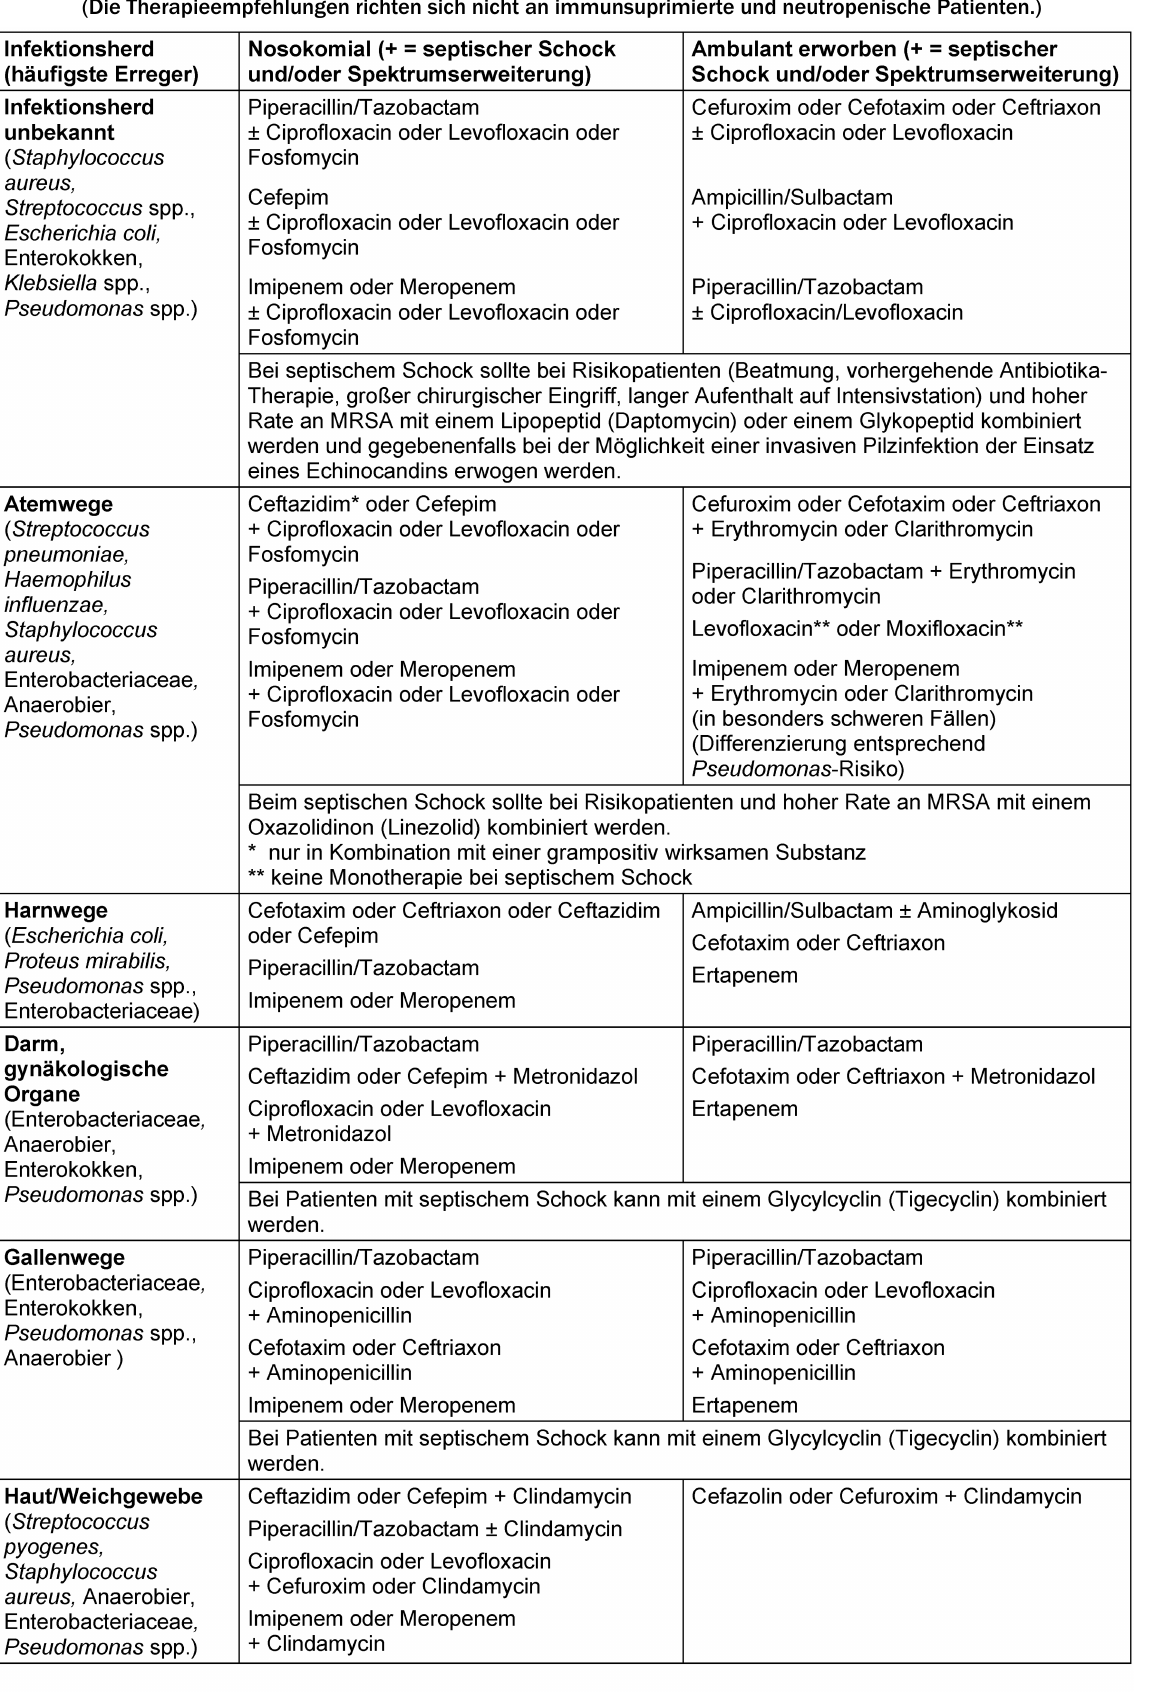
Tabelle 1: Empfehlungen zur Therapie der Sepsis bei unbekanntem